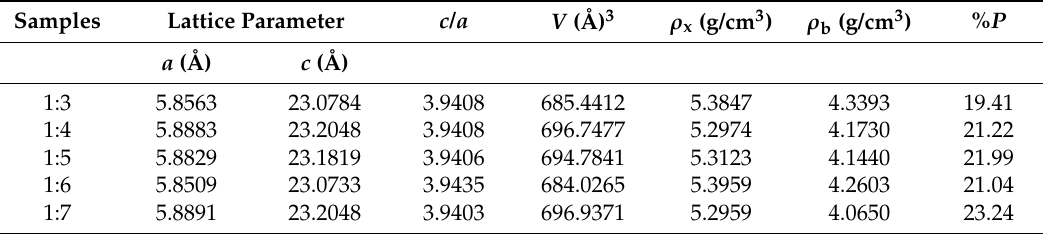
Table 2. Lattice constants a and c , c / a ratio, volume of unit cell, V , particle size, D , X-ray density, ρ x , bulk density, ρ b and porosity, % P for BaFe 12 O 19